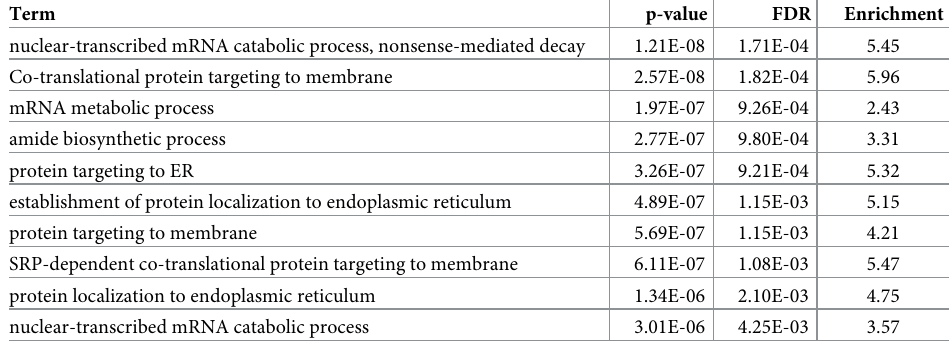
Table 1. Gene ontology analysis of genes whose promoter contain at least one CGCG